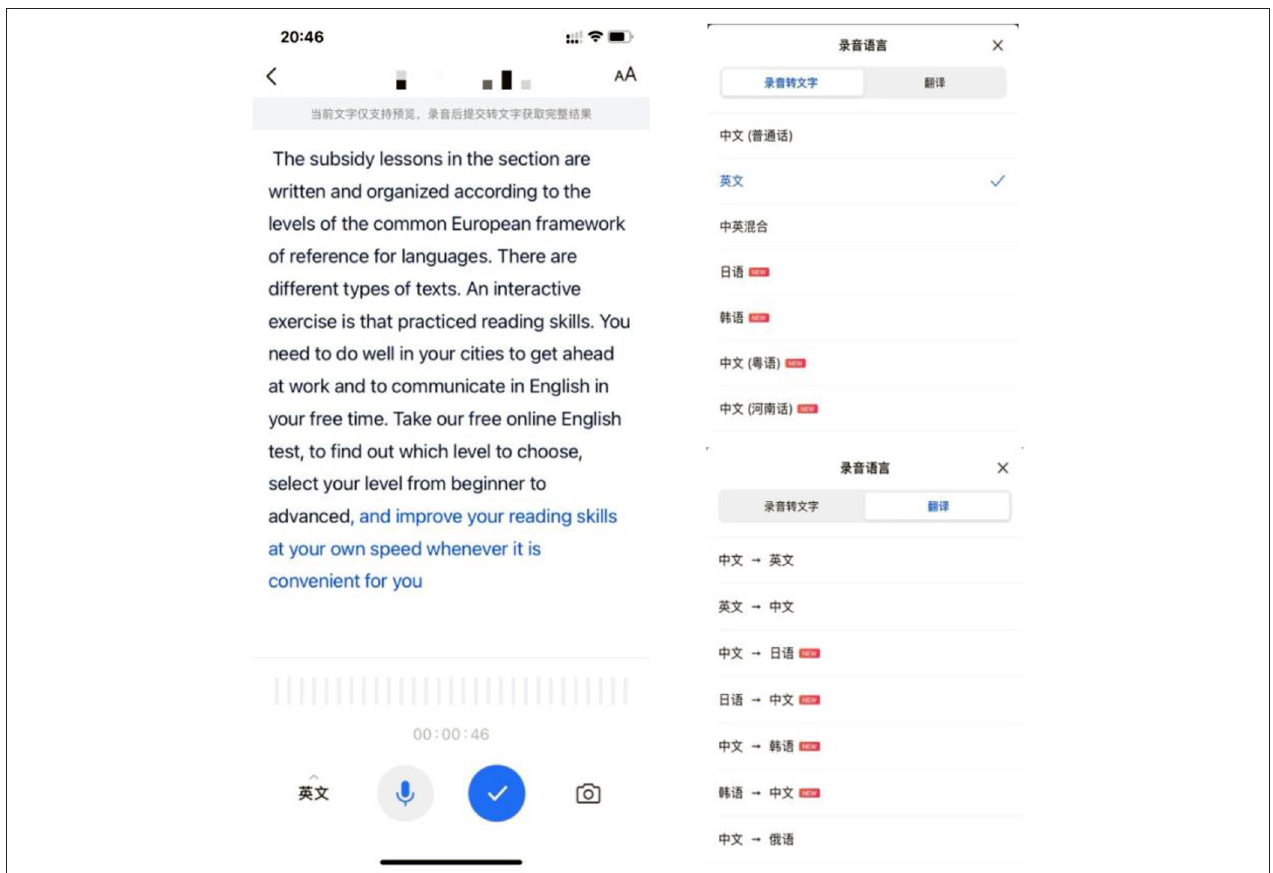
FIGURE 2 | Screen capture of iFlyRec application. Reproduced with